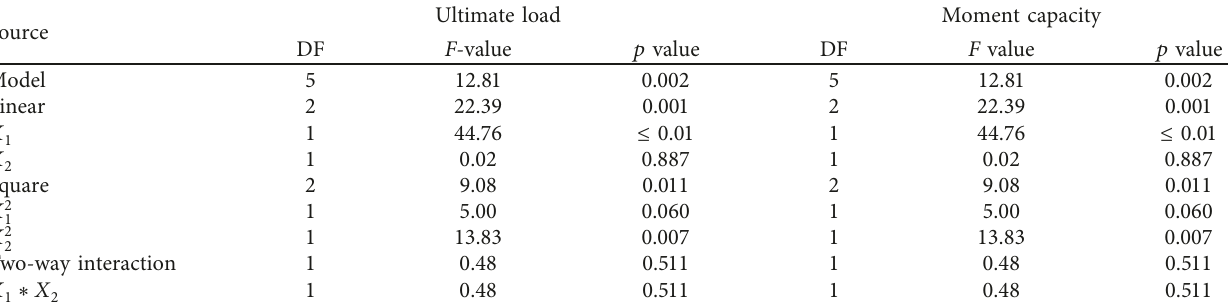
Figure 4: Normality graph of (a) ultimate load; (b) moment capacity. Table 4: ANOVA for ultimate load and moment capacity.